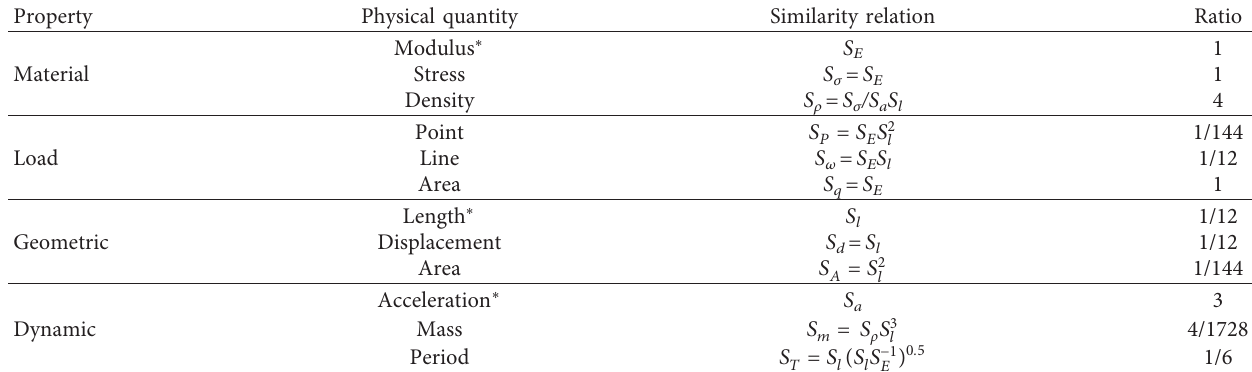
Table 2: Similitude parameters and similarity ratios of the shaking table